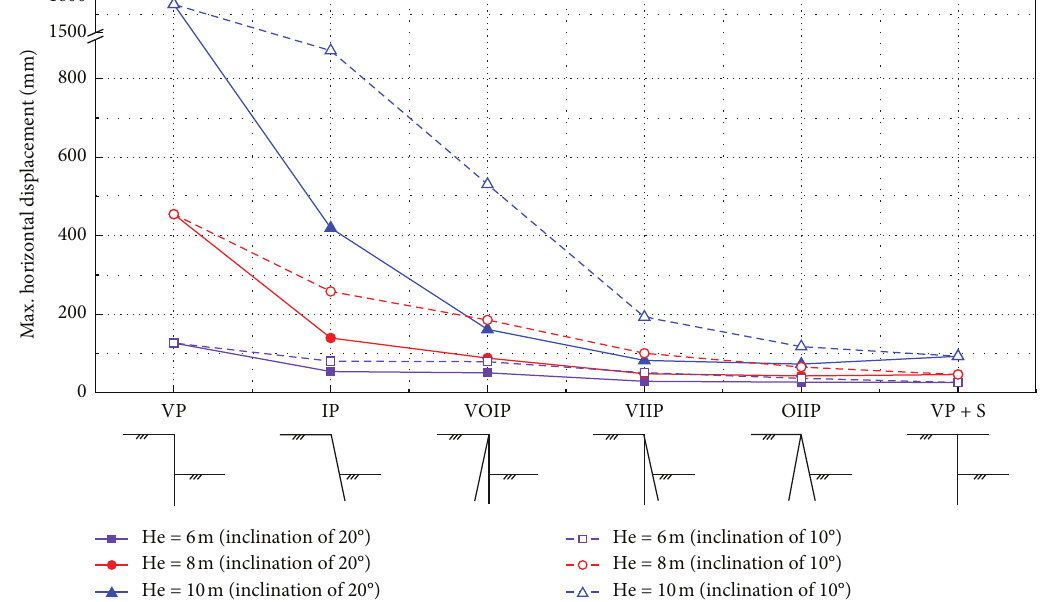
Figure 7: The maximum horizontal displacements of the retaining